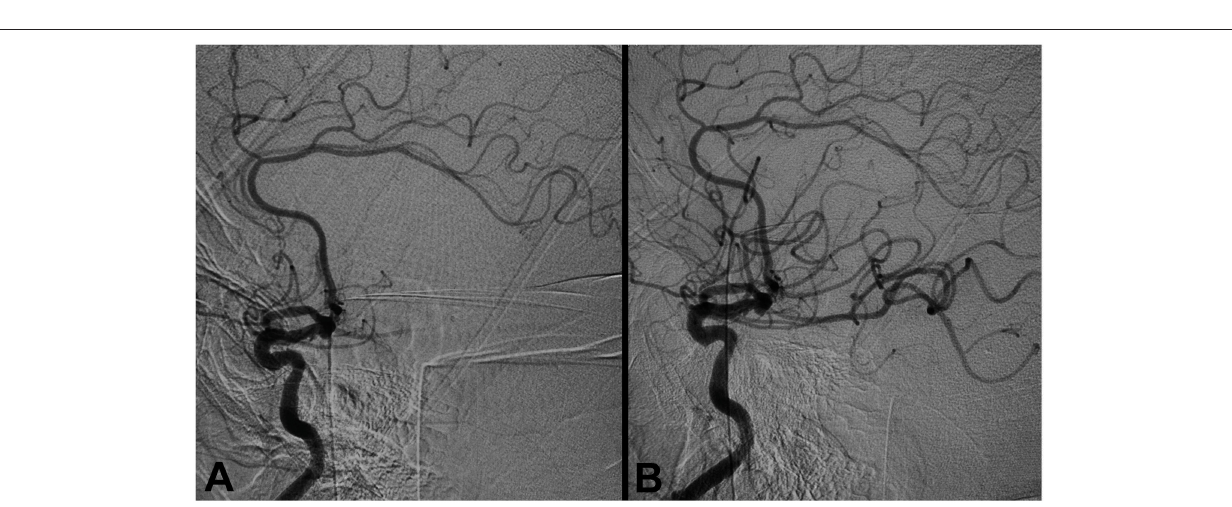
FIGURE 5 | Aspiration thrombectomy for right middle cerebral artery occlusion. (A) Pre-procedure angiogram demonstrating occlusion of the right M1 segment (TICI 0). (B) Post-thrombectomy angiogram demonstrating TICI 3